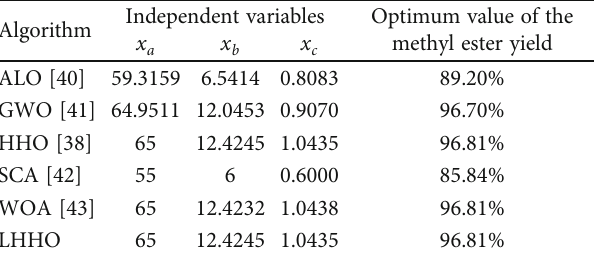
Table 5: Comparative result analysis of biodiesel output using participating algorithms.